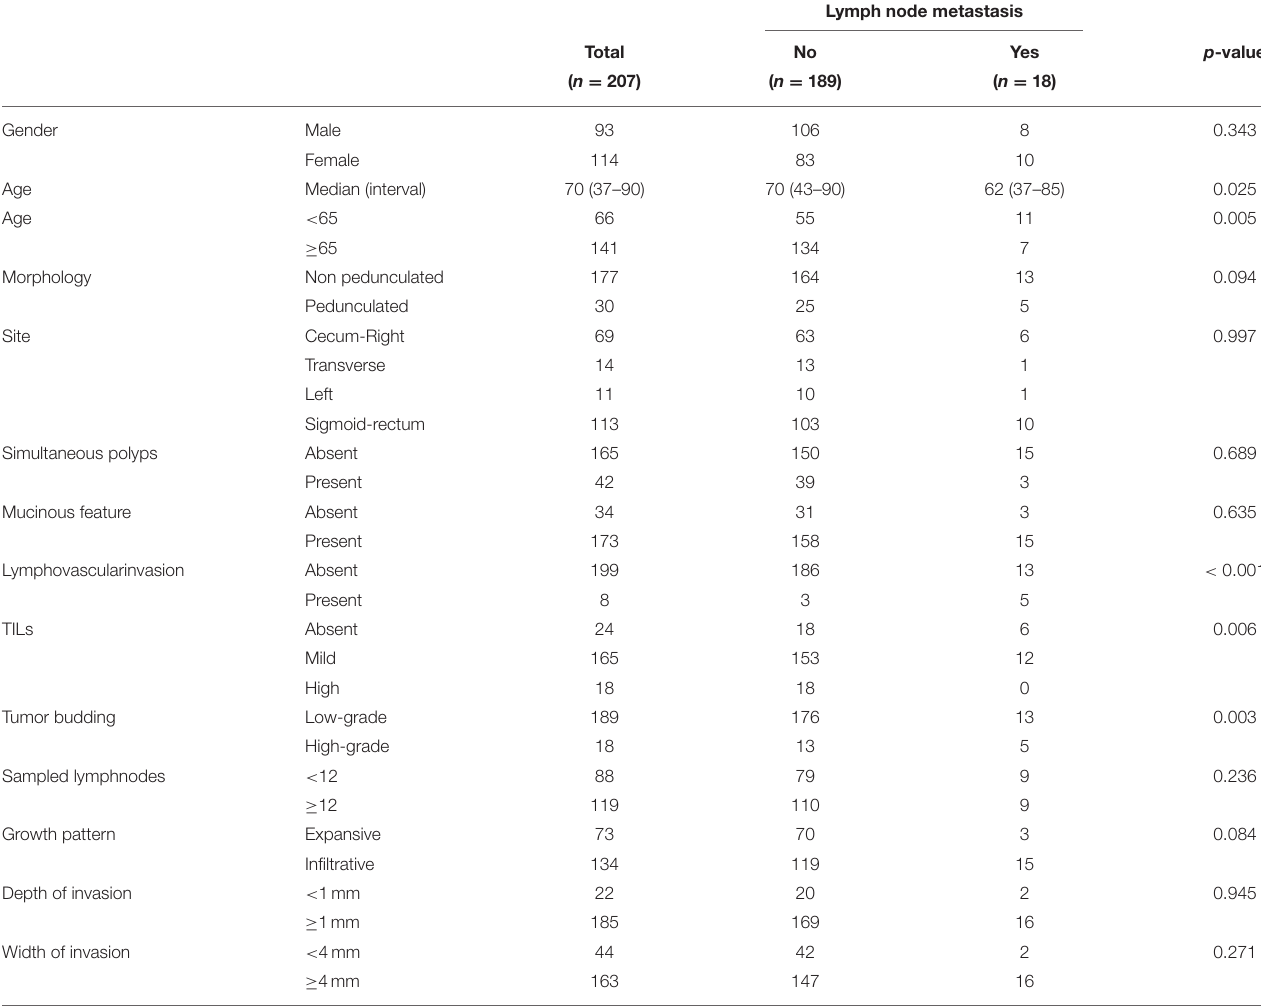
TABLE 2 | Distribution of clinical data and pathological features based on lymph nodes metastasis.